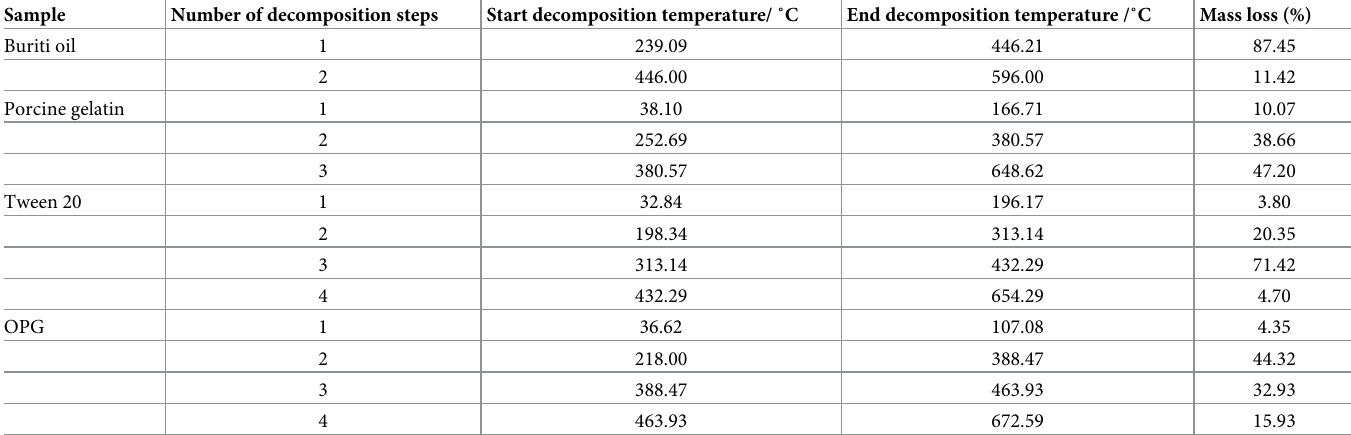
Table 1. The stages (TG) and mass loss of buriti oil, porcine gelatin, Tween 20 and OPG. Sample Number of decomposition steps